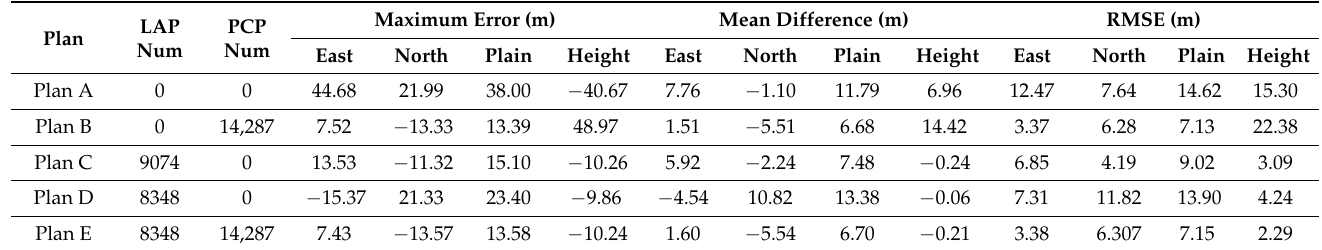
Table 2. Total Adjustment Results of ZY-3 Stereo